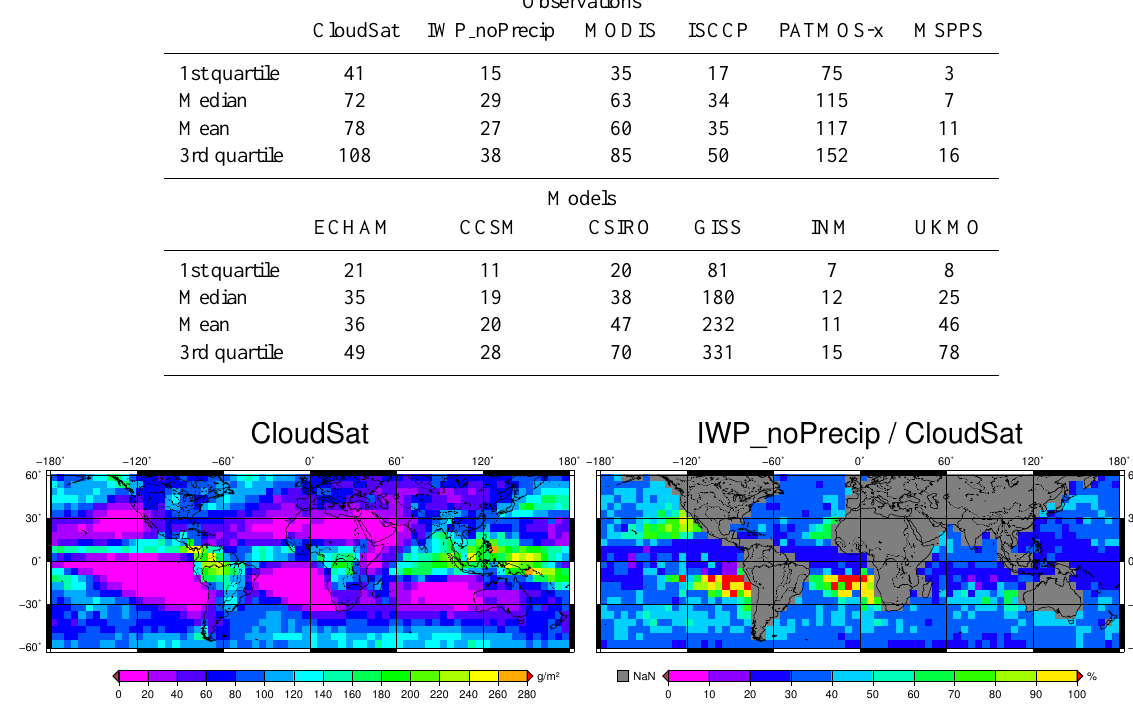
Gaussian and have quite different shapes from each